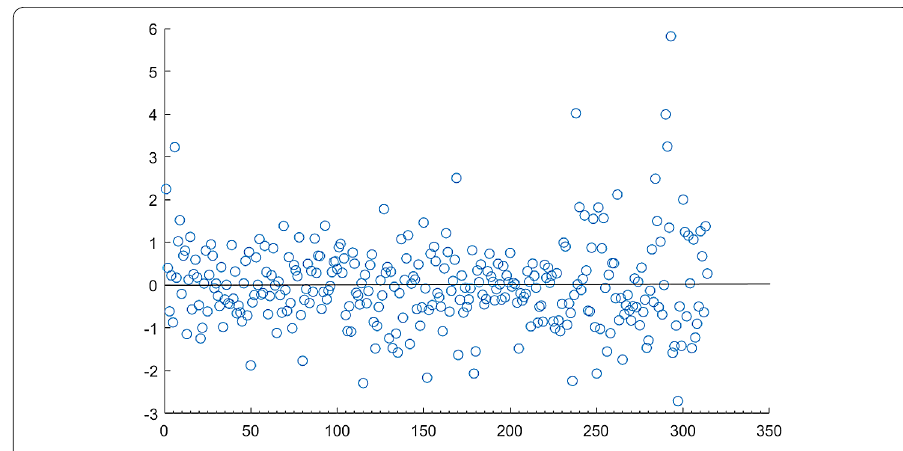
Figure 2 Heteroscedasticity test scatter plot